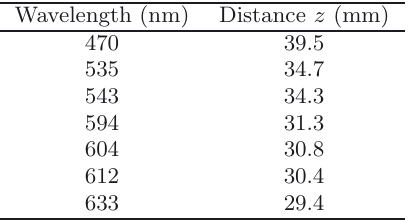
Table 1. Laser wavelengths and their corresponding aperture separation distances, used in the experiments.